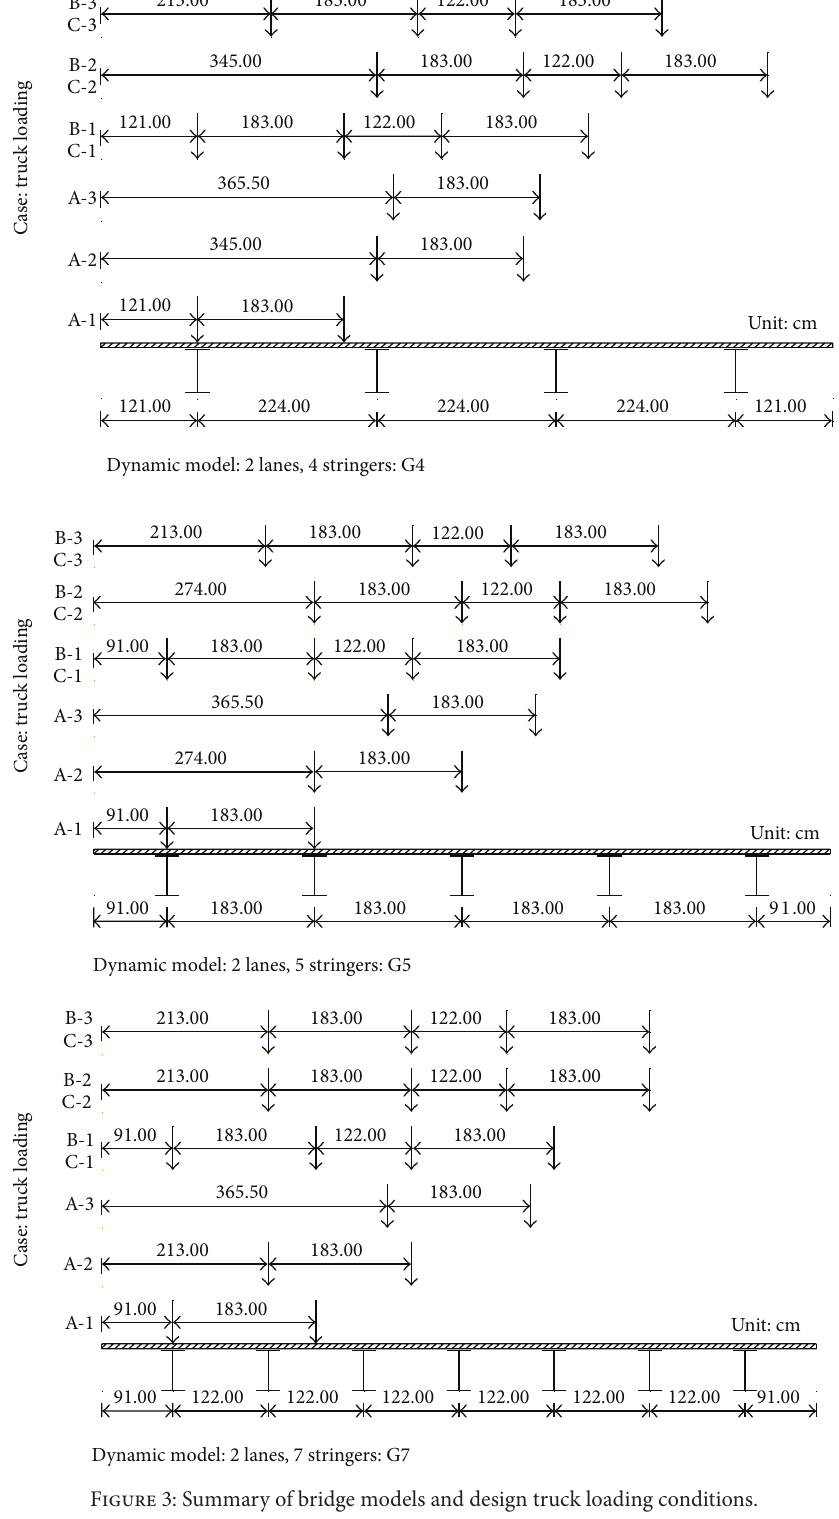
Figure 3: Summary of bridge models and design truck loading